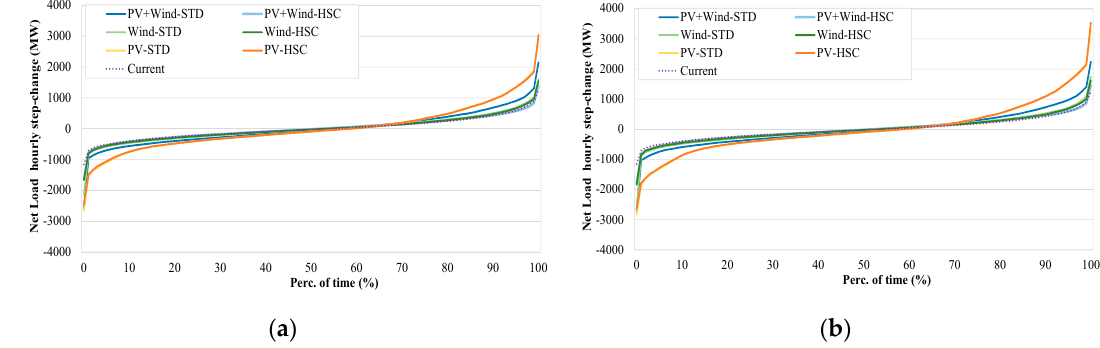
Figure 11. Duration curve of the net load hourly step change using a Surplus (cid:2923)(cid:2911)(cid:2934). equal to ( a ) 5% and ( b ) 10%.